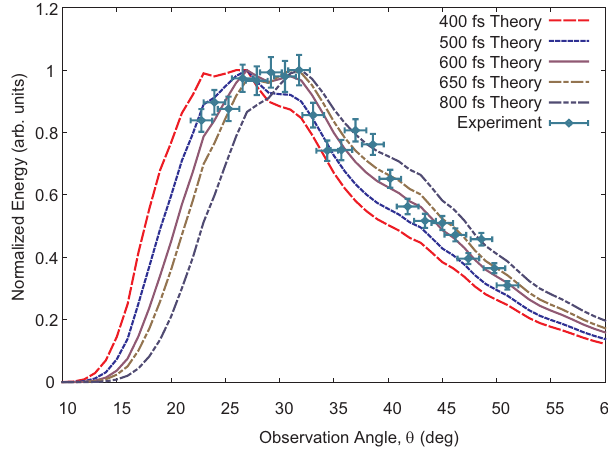
FIG. 5. (Color) Plot of the angular distribution of SPR normal- ized energy from the 10 mm grating as measured by the Si bolometer. The theoretical curve is shown for a 15 MeV beam with a 1.0 ps FWHM Gaussian longitudinal distribution, and 1 mm FWHM Gaussian transverse distribution. First published in [15].